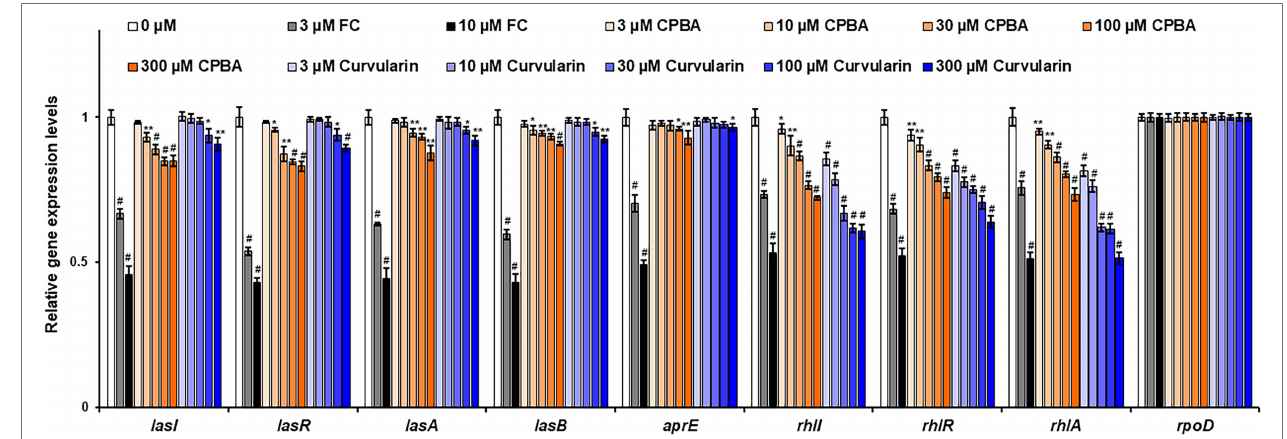
FIGURE 5 | Effects of curvularin on QS gene expression. PA14 cells were cultured in LB medium containing different concentrations of curvularin for 12 h. The effects of curvularin on QS gene expression were measured by RT-qPCR. FC and CPBA are known antagonists of LasR and RhlR, respectively. The experiment shown is representative of three independent experiments performed in triplicate and the mean ± SD values are presented in each bar. * p < 0.05; ** p < 0.01; and # p < 0.001 versus DMSO